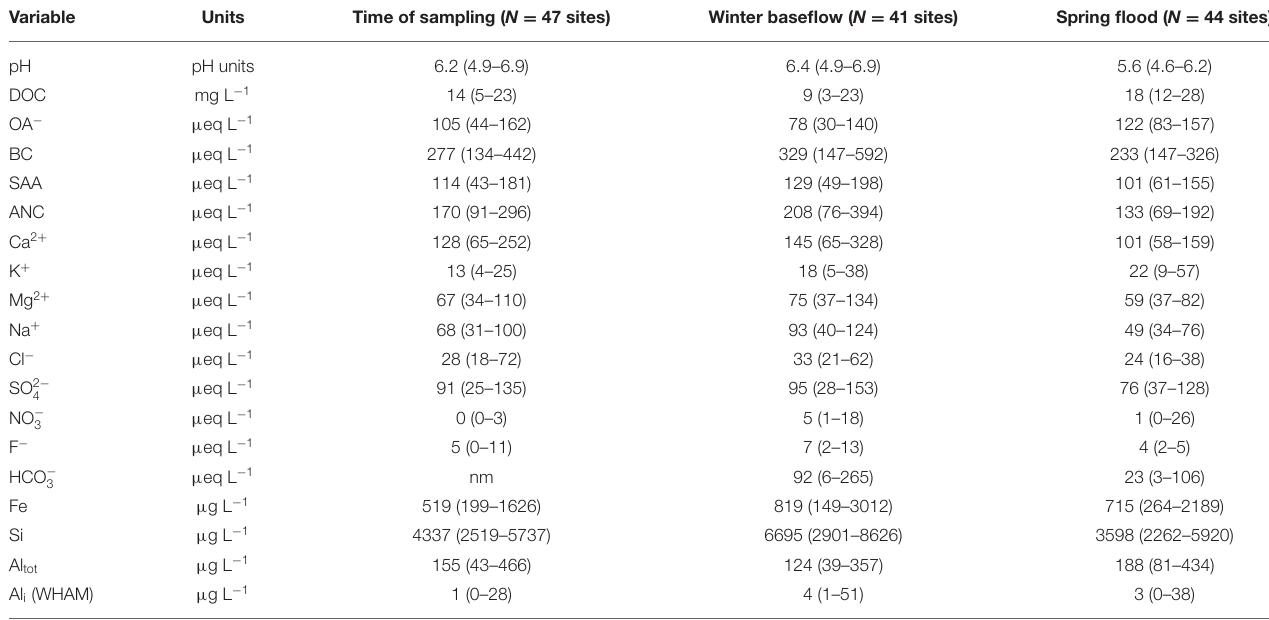
TABLE 3 | Median (range) of chemistry parameters for the electrofishing sites during three different sampling periods. Variable Units